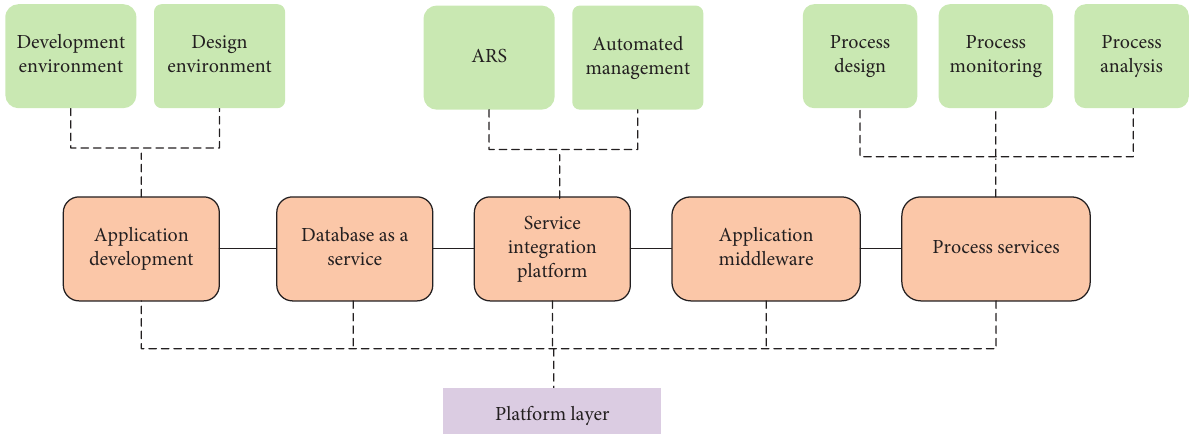
Figure 3: Cloud audit platform